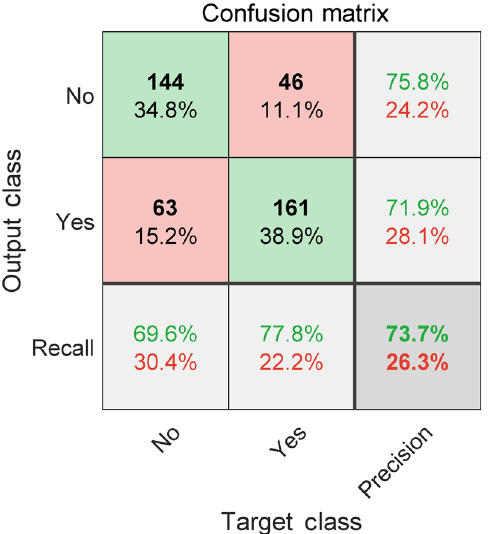
Fig. 2 Confusion matrix of the optimized decision tree model. Blue diagonal and red non-diagonal elements represent the correct and wrong prediction, respectively.